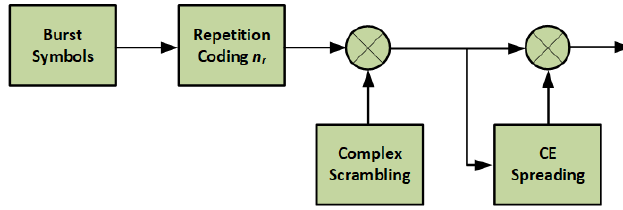
Figure 3. Constant envelope spreading modulator structure.